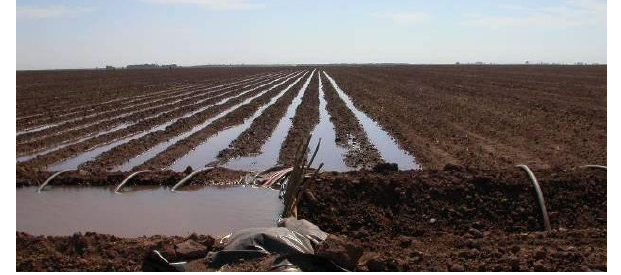
Fig. 3. Satellite acquisition dates ( × Formosat-2, + Envisat/ASAR) together with the main phenological stages of wheat crops. The ASAR acquisition mode is indicated (top number: ascending overpass; bottom number: descending overpass; the number indicates the illumination/viewing angle from IS1 to IS6).